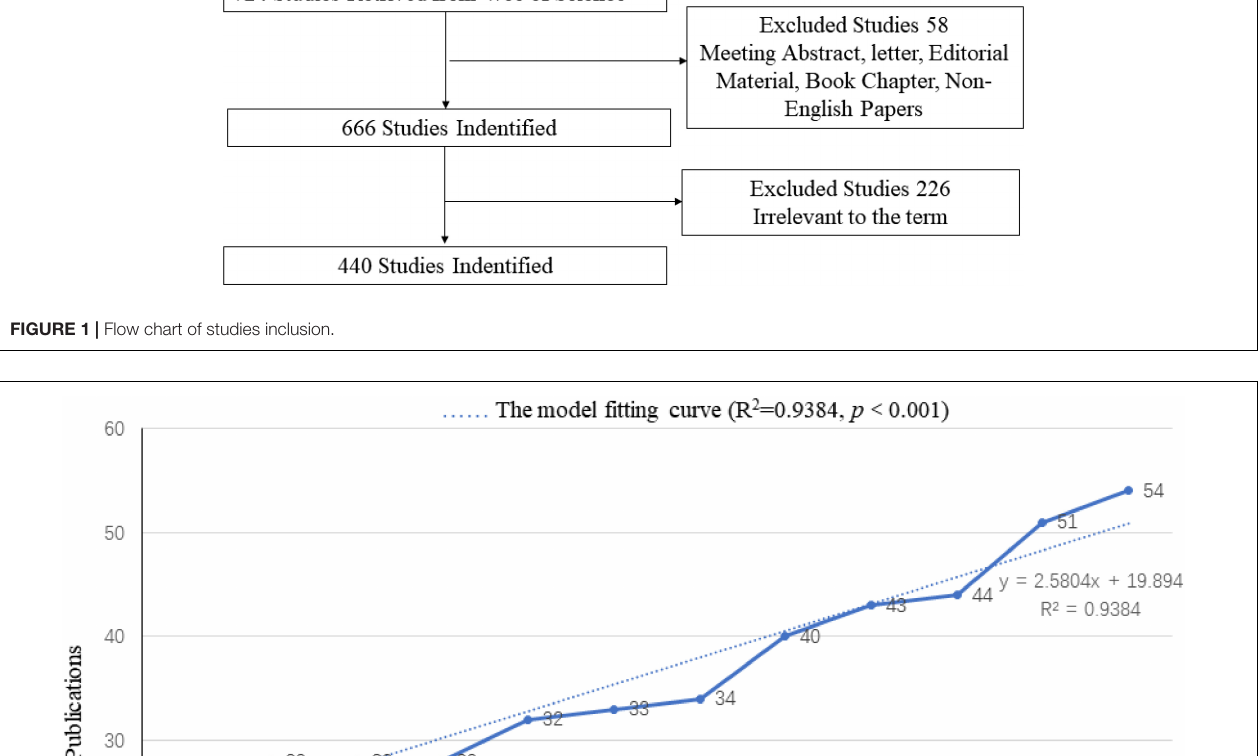
Frontiers in Human Neuroscience |